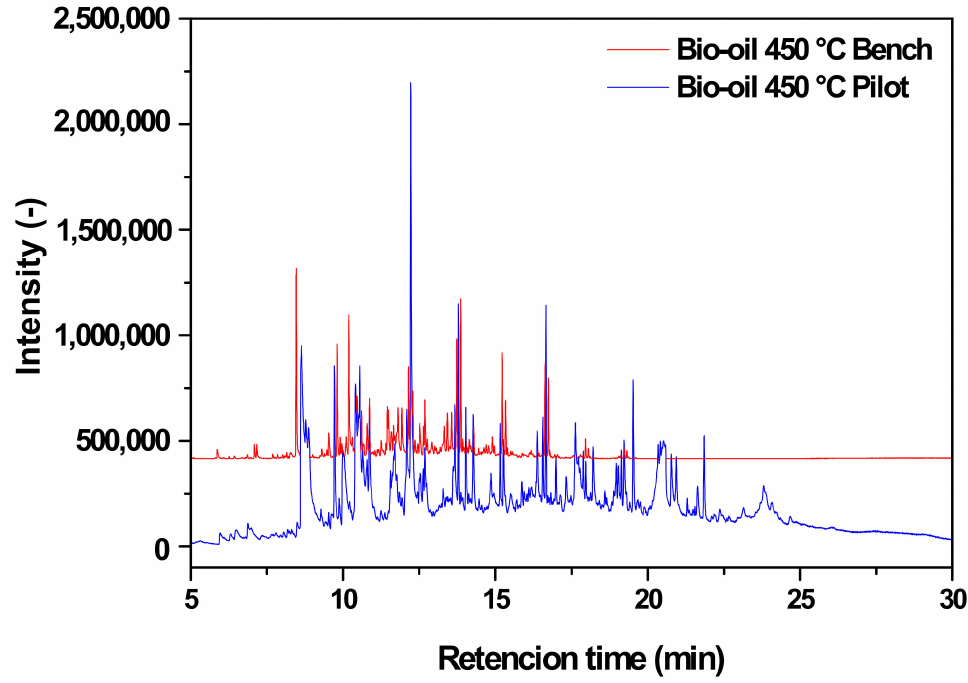
Figure 12. Chromatograms of bio-oils obtained in bench and pilot